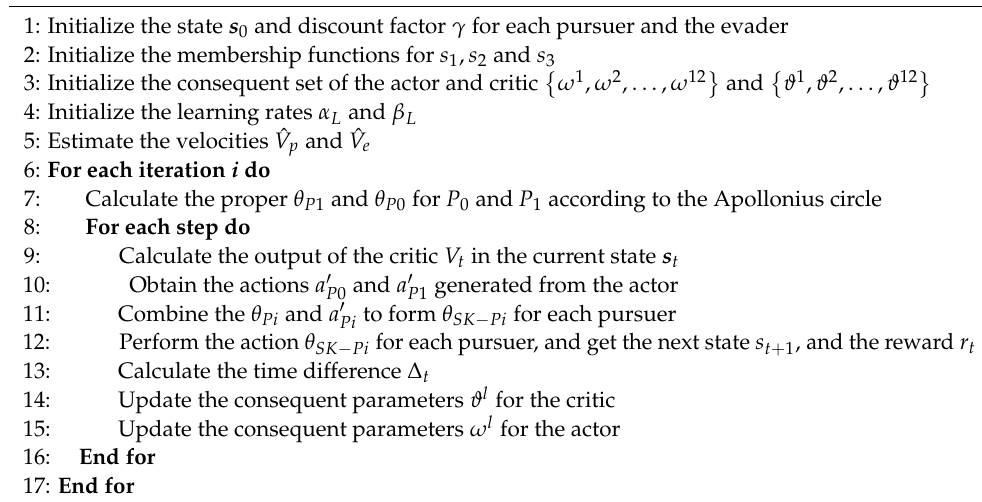
Algorithm 1 Accelerating fuzzy actor–critic learning algorithm via suboptimal